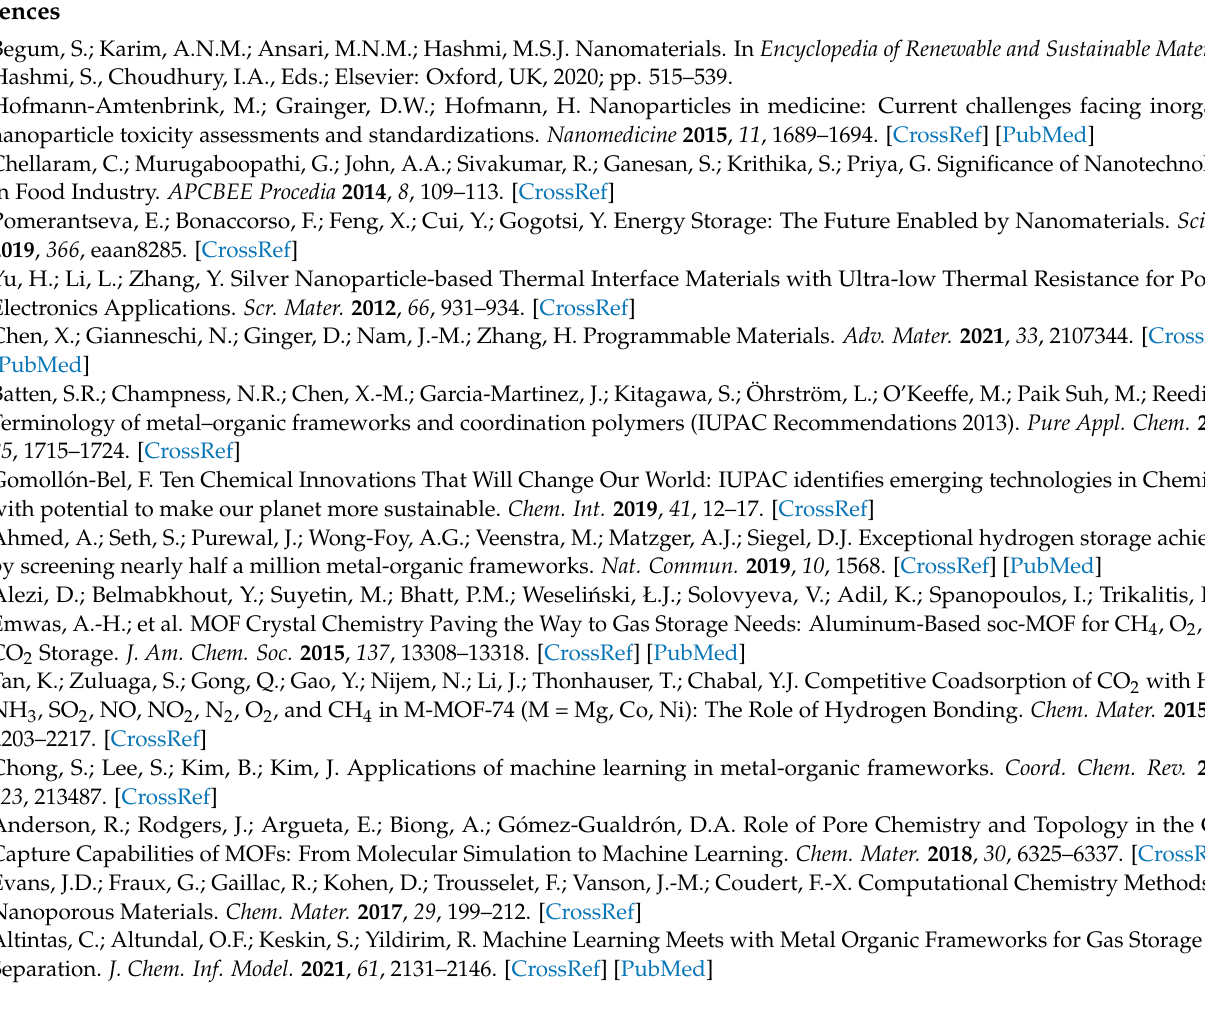
Figure S34 and S35: Performance of MLP/LSTM model in 100 repeated holdout validations for methane adsorption in the mixture of MOFs and COFs at 65